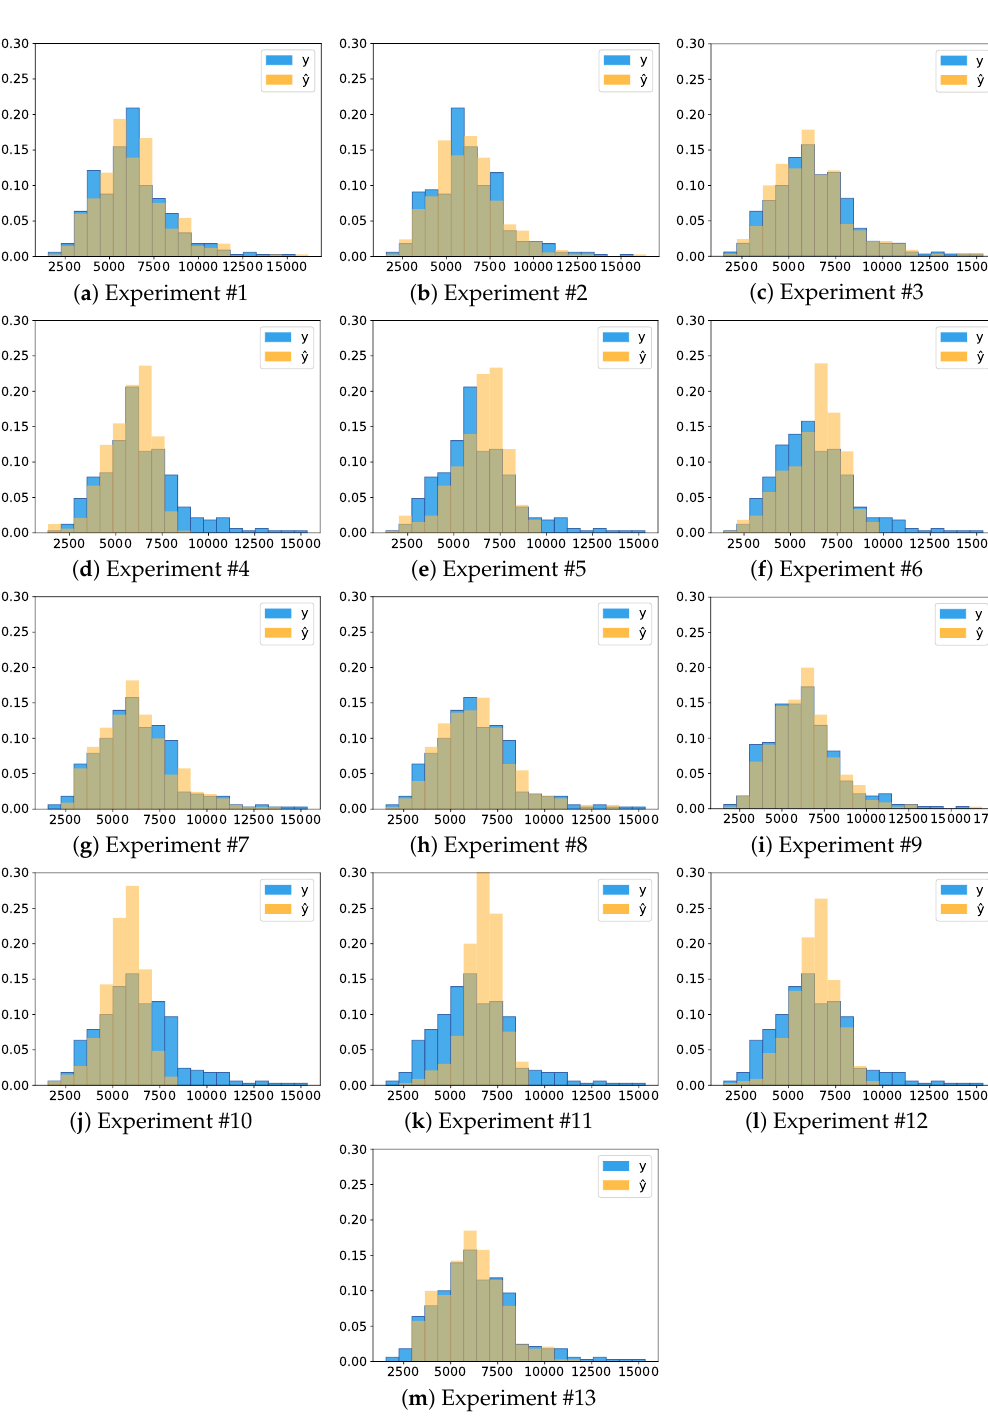
Figure 7. Comparison of prediction ˆ y vs. real y data distribution. Larger intersecting areas between histograms indicates better